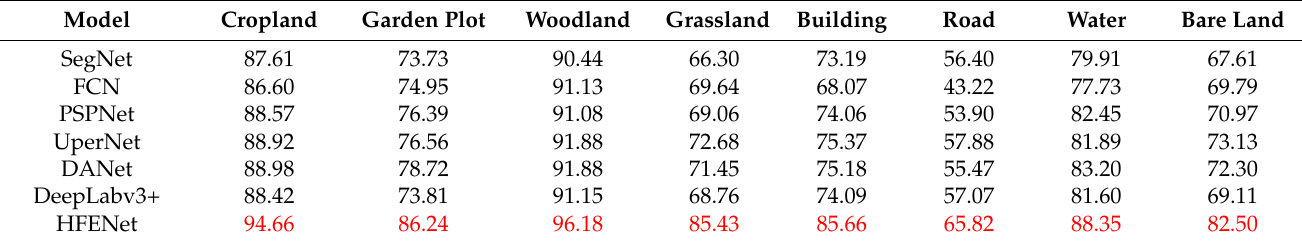
Table 5. The IoU values for each category of the state-of-art models on the MZData (%).